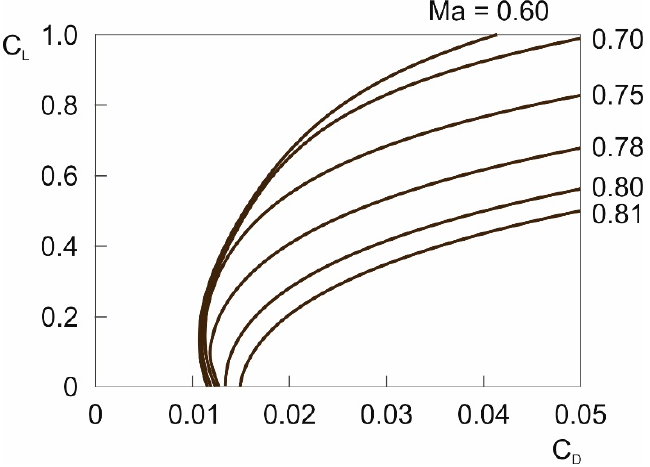
Figure 4. Drag coefficient of straight wing configuration dependent on lift coefficient, C L and Mach number, Ma , [7].